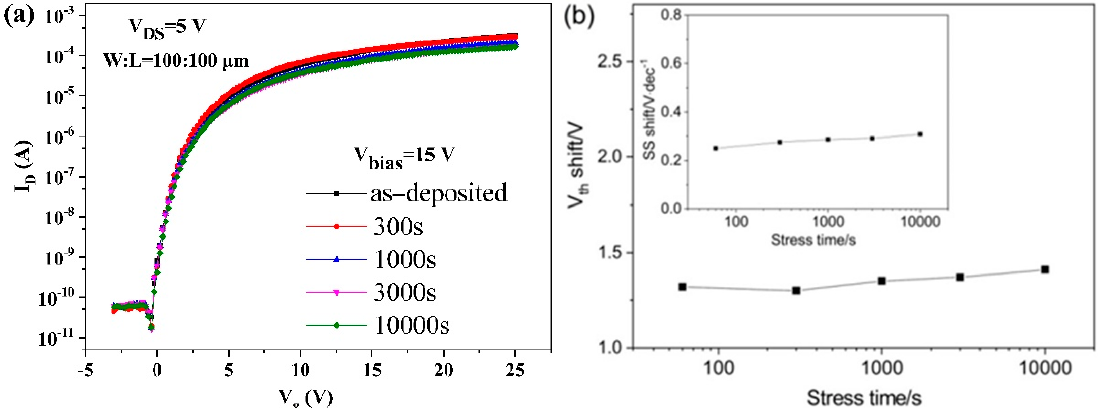
Figure 9. Transfer curves with SZHS based a-IGZO TFT. ( a ) Under different PBST; ( b ) the V th shift of vs. PBST (inset is the SS shift of vs. PBST).